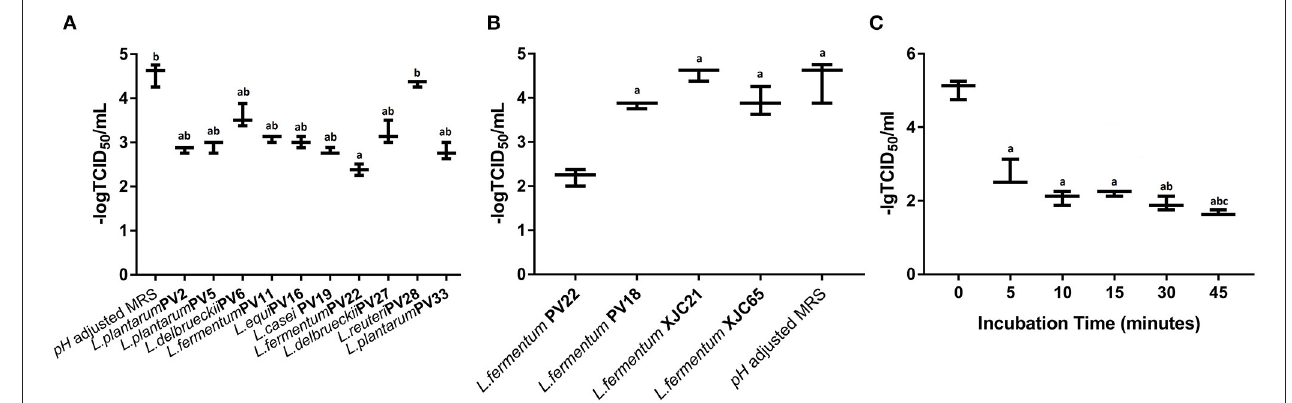
FIGURE 3 | Antiviral activity of the most potential minimum non-toxic dilution (MNTD) obtained from different lactic acid bacteria (LAB) isolates. (A) The antiviral activity of the MNTDs from the ten Limosilactobacillus strains with the most antiviral potential during a 15min incubation; pH-adjusted MRS was used as control. a indicates P < 0.05 compared to control; b indicates P < 0.05 compared to L. fermentum PV22. (B) The antiviral activity of MNTDs from four different isolated strains of L. fermentum during 15min incubation; pH-adjusted MRS was used as a negative control. a indicates P < 0.05 compared to L. fermentum PV22. (C) The antiviral activity of MNTDs of L. fermentum PV22 at different incubation periods. The murine norovirus (MNV) titer determined as 50% tissue culture infectious dose (TCID 50 ), shown as dot, with the mean ± standard deviation in bars; a indicates P < 0.01 compared to the 0-min group, b indicates P < 0.05 compared to the 5-min group whereas c indicates P < 0.05 compared to both the 15-min and 30-min groups.